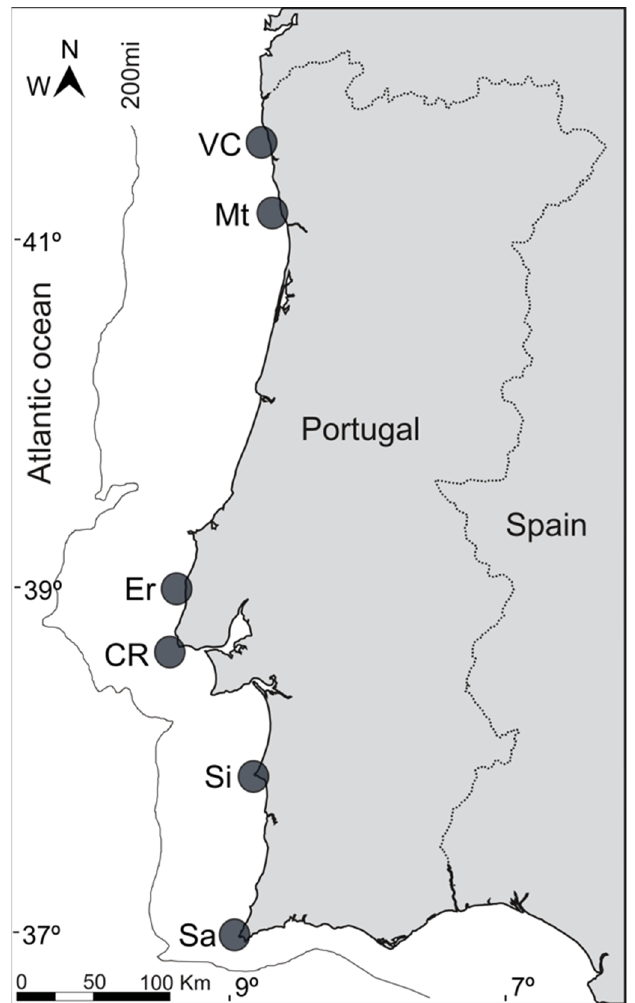
Figure 6. Location of the sampling sites of the specimens evaluated in the present study along the Portuguese Western coast (VC—Viana do Castelo; Mt—Matosinhos; Er—Ericeira; CR—Cabo Raso; Si—Sines; Sa—Sagres).